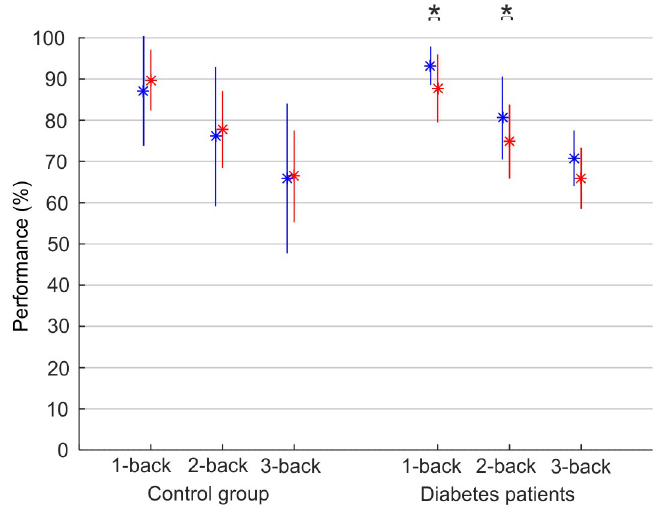
Fig 1. Working memory performance in the fMRI investigation during hyperglycaemic or placebo clamp. Performance was measured as the percentage of correct answers during n-back tests (1-back, 2-back, and 3-back). The placebo was saline infusion (blue); hyperglycaemic clamp is shown in red. Data are reported as mean ± SD. � p < 0.05 between saline infusion and hyperglycaemic clamp.